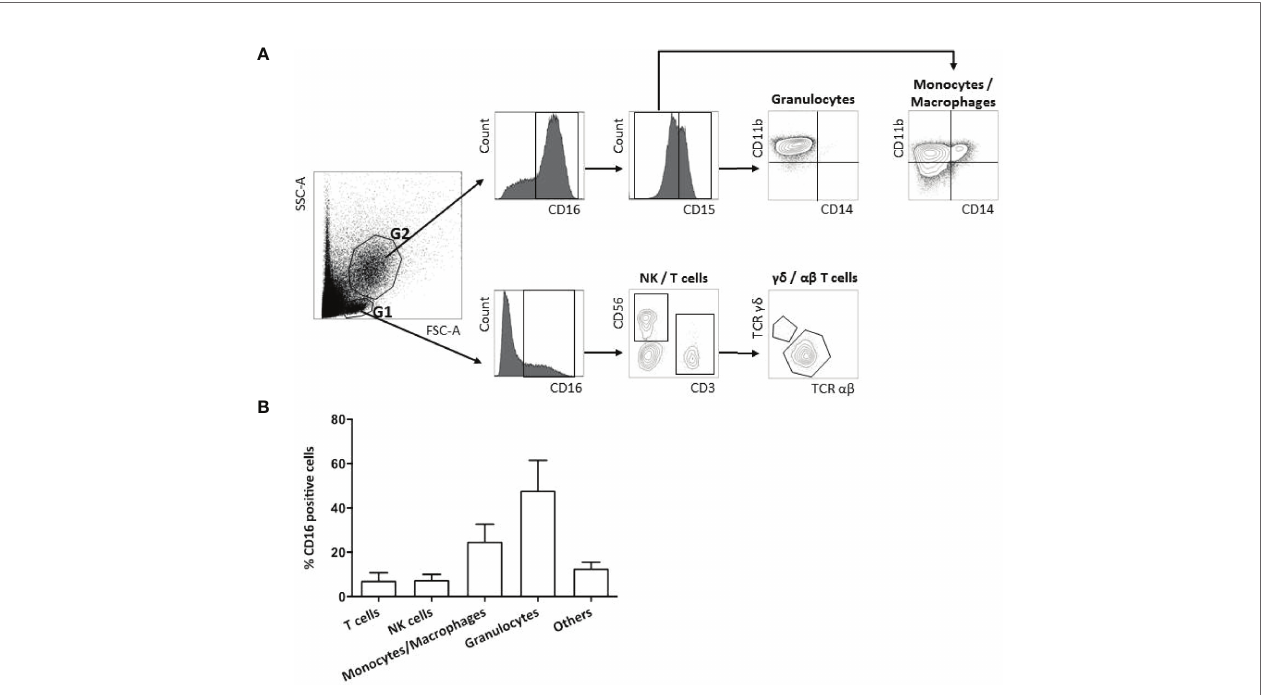
FIGURE 1 | Fc g RIIIA (CD16) expression on tumor-in fi ltrating immune cells. Flow cytometry gating strategy of Fc g RIIIA (CD16) expression on a representative primary tumor sample from a CRC patient (A) . Fc g RIIIA (CD16) positive cells are gated among the living lymphoid (G1) and myeloid (G2) cells and different immune sub- populations are highlighted according to their phenotype: T cells (CD3 + TCR ab + or gd + ), NK cells (CD3 − CD56 + ), monocytes/macrophages (CD15 − CD11b + CD14 − /low ) and granulocytes (CD15 + CD11b + CD14 − ). Frequency of Fc g RIIIA (CD16) positive in fi ltrating immune sub-populations among total Fc g RIIIA + (CD16) positive living cells from the 4 non metastatic CRC patients included prospectively. The bar charts represent mean +/- standard deviation (B)